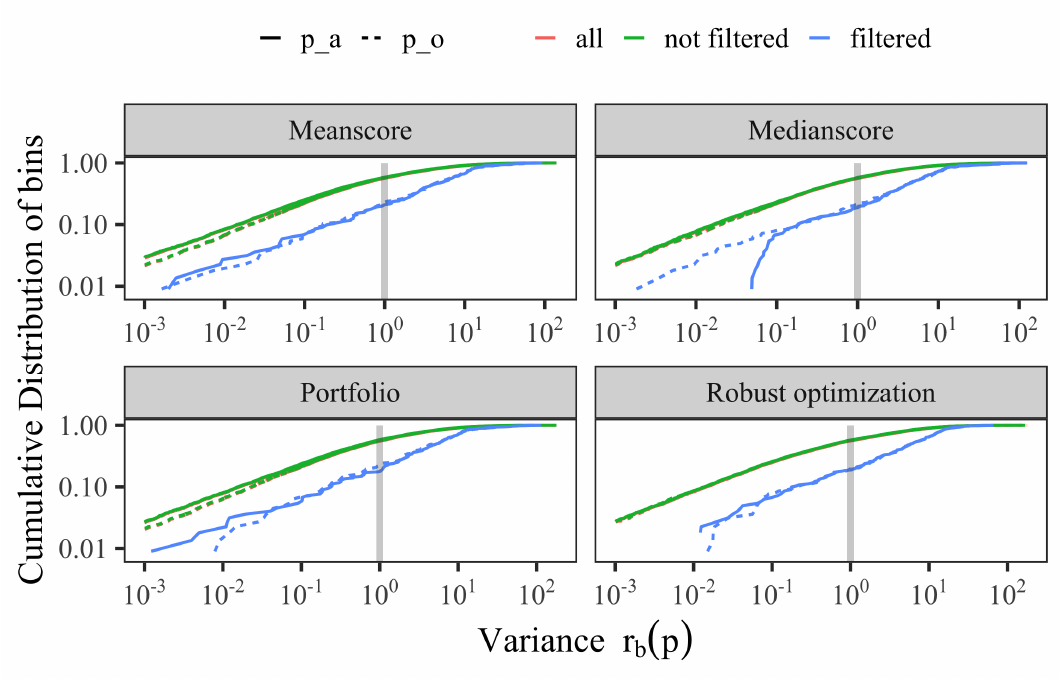
Figure 13: Same as Figure 12, but using observable